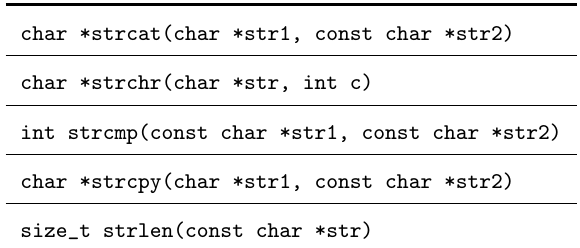
Table 1. String functions syntax in C